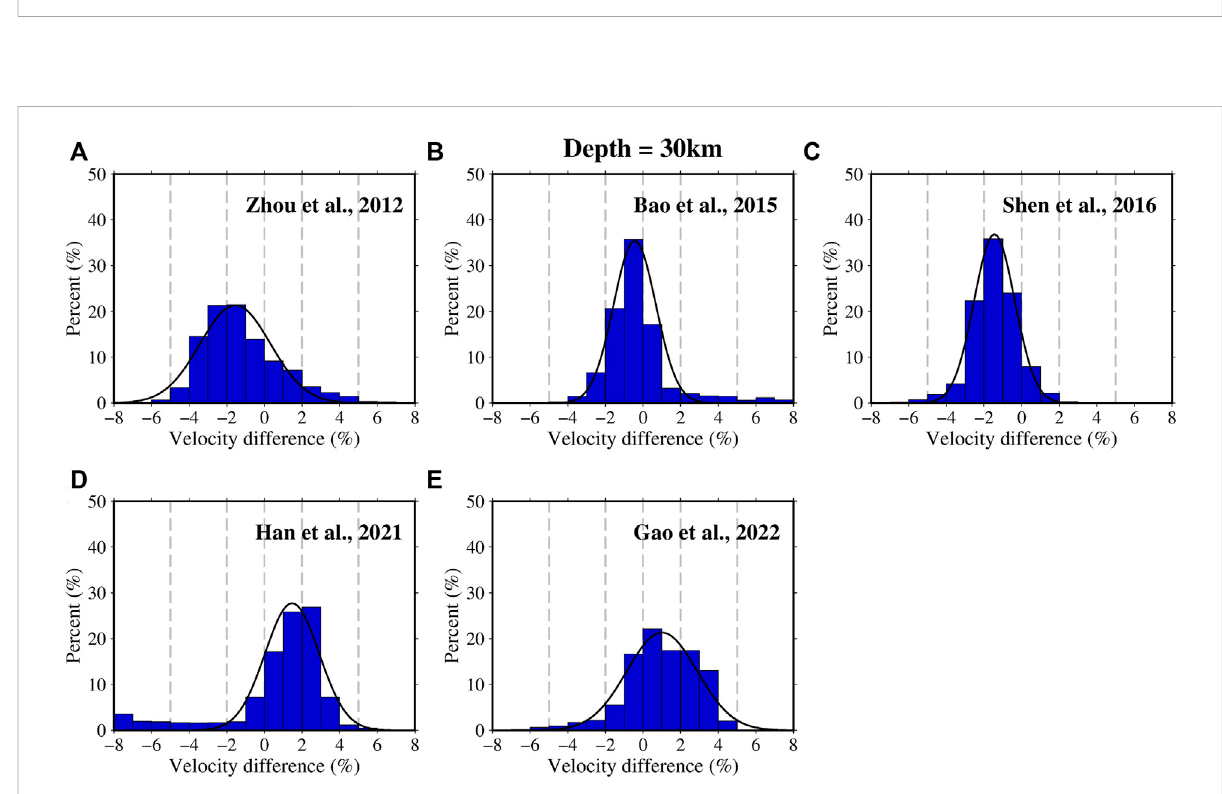
FIGURE 12 Percentage histograms of velocity difference distribution from the average model, calculated at each node, at 30 km depth for (A) Zhou et al. (2012), (B) Bao et al. (2015), (C) Shen et al. (2016), (D) Han et al. (2021), (E) Gao et al. (2022). The dashed gray lines indicate the velocity difference of 0%, ± 2%, and ±